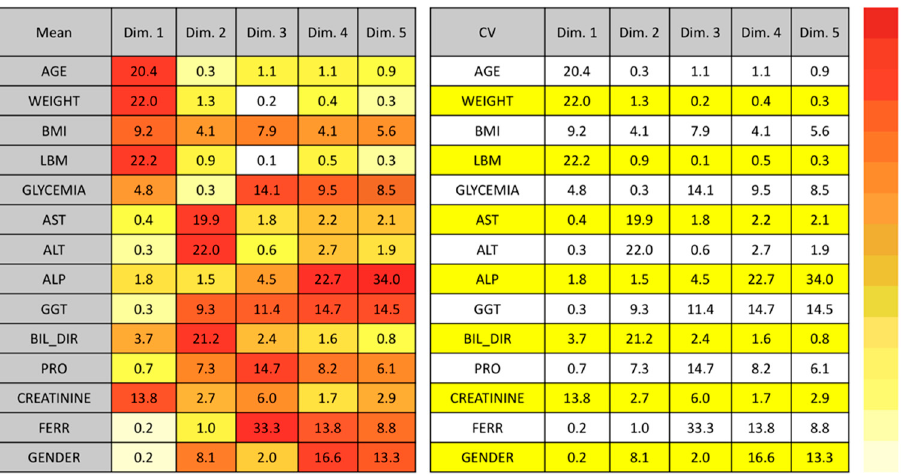
Table 1. Demographic characteristics of patients enrolled in the present study.